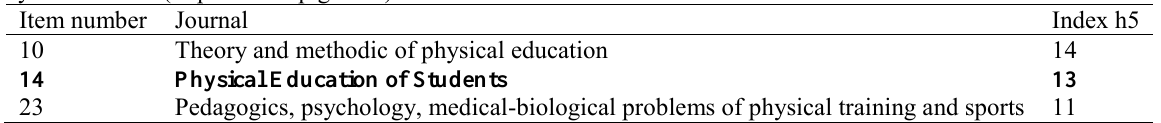
Table 3. Rating of journals in data base “Bibliometryka of Ukrainian science” (ТOP 200, all sciences) for 2010–2014 by indicator h5 (http://nbuviap.gov.ua)